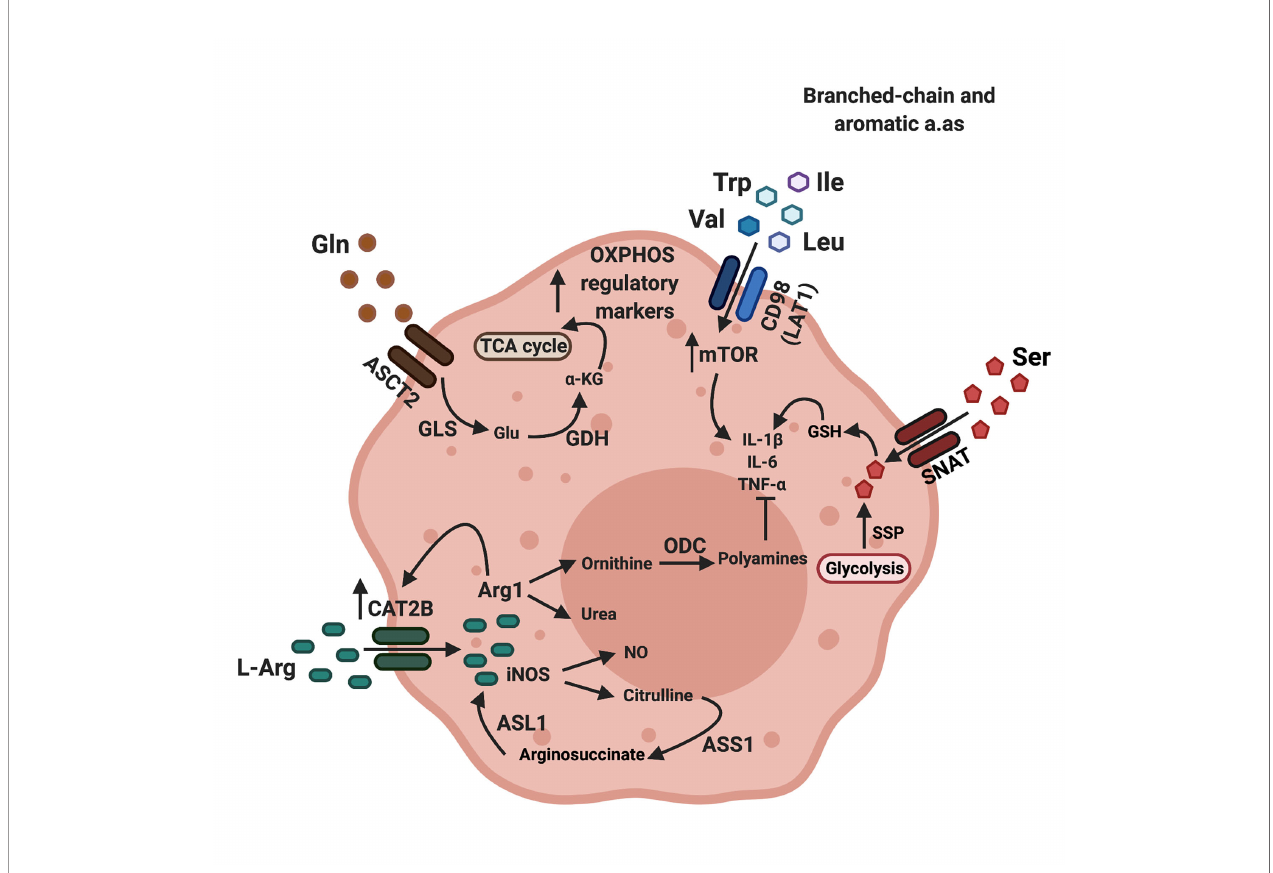
FIGURE 1 | Amino acid transporters regulate amino acid availability and macrophage polarization. Arginine enters macrophages through cationic amino acid transporters (CAT), while glutamine and aromatic or branched chain amino acids enter macrophages though the neutral amino acid transporters ASCT2 (alanine serine cysteine transporter 2) and LAT1 (large amino acid transporter 1) respectively. Arginine can be catabolized by either arginase-1 (Arg1) or nitric oxide synthase (iNOS). Citrulline, a metabolite produced by the action of iNOS can be converted back to arginine by the enzymes arginosuccinate synthetase (ASS1), which converts citrulline to arginosuccinate and arginosuccinate lyase (ASL1), which converts arginosuccinate back to arginine. The net positive fl ow and accumulation of amino acids in macrophages through amino acid transporters result in increased mTOR activity and production of pro-in fl ammatory cytokines such as IL-1b and TNFa. The product of arginase 1-mediated arginine catabolism, ornithine, is converted to polyamines through the action of ornithine decarboxylase (ODC). When Glutamine (Gln) enters macrophages, it is converted to glutamate (Glu) by glutaminase (GLS), and in turn, glutamate will be converted to a-ketogluterate (a-KG) by glutamate dehydrogenase (GDH). Ornithine, polyamines and a-ketoglutarate directly inhibit synthesis of in fl ammatory macrophage markers and promote the production of regulatory macrophage markers by feeding into the TCA cycle, leading to a regulatory phenotype (7, 21, 22). Image created using